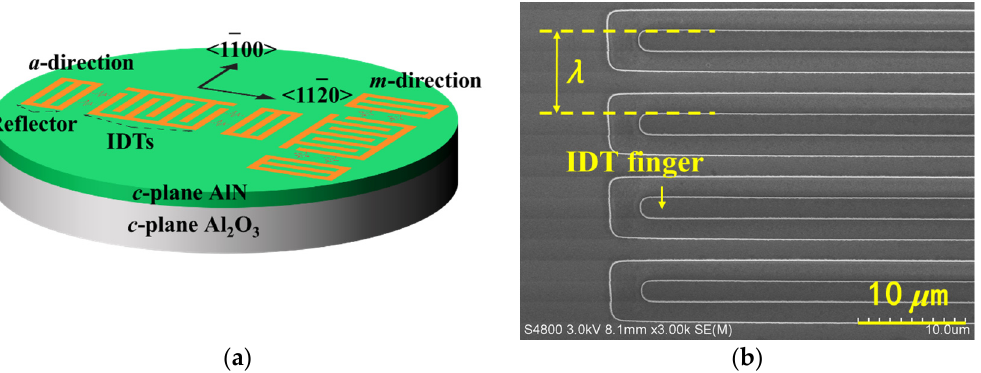
Figure 1. ( a ) Schematic picture of SAW sensors with different directions; ( b ) SEM image of IDT fingers. Table 1. Device parameters of fabricated AlN/sapphire-based SAW sensors.